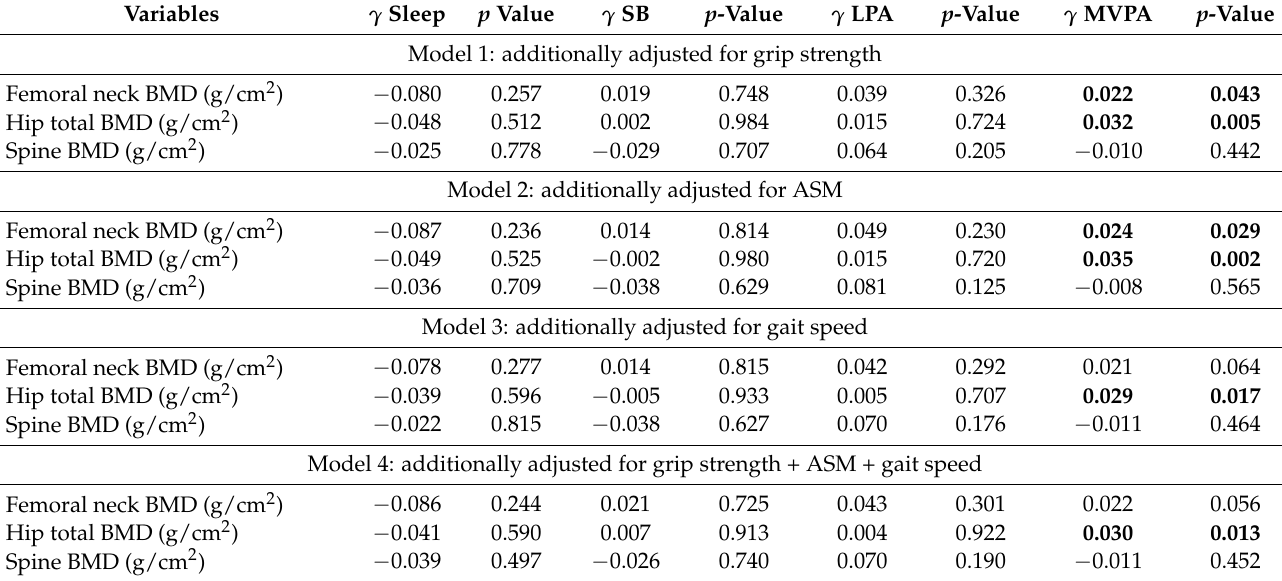
Table 4. Compositional linear regression model for South African cohort between bone mineral density variables and movement behaviors considering bone-muscle